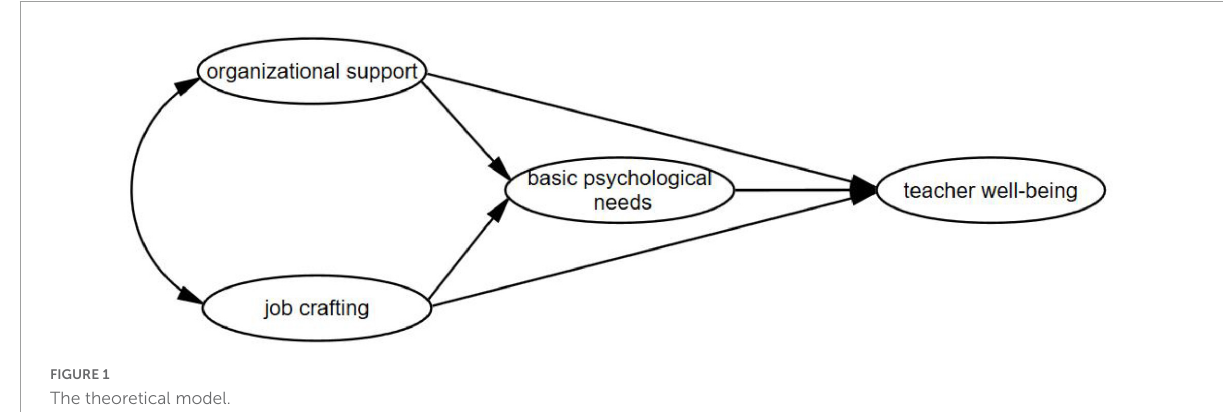
FIGURE1 The theoretical model.